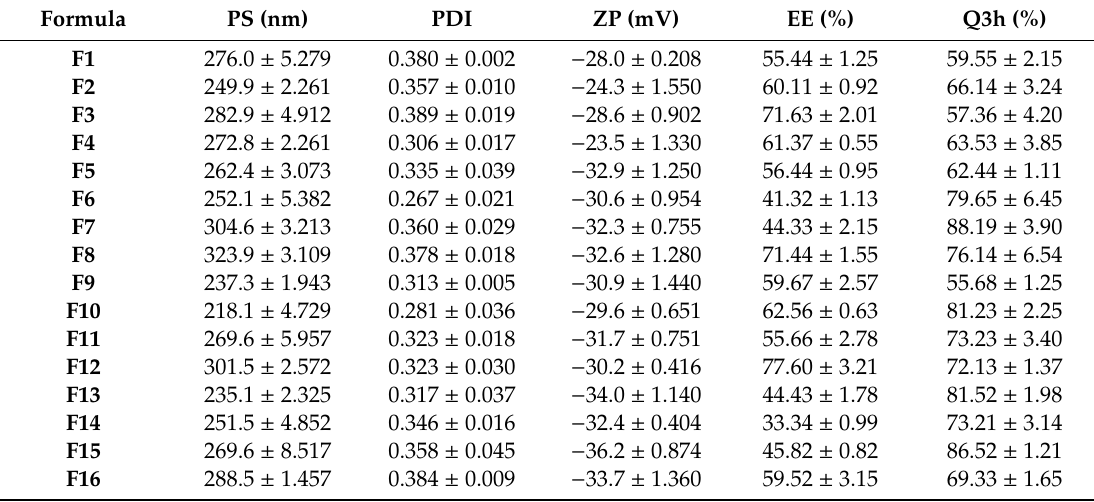
Table 2. Particle size (PS), polydispersity index (PDI), zeta potential (ZP), entrapment e ffi ciency